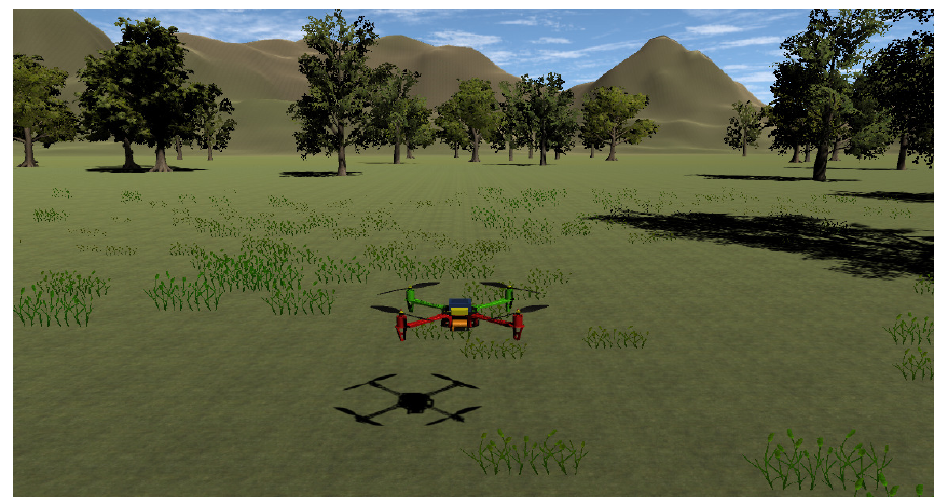
Figure 6. The 3D virtual